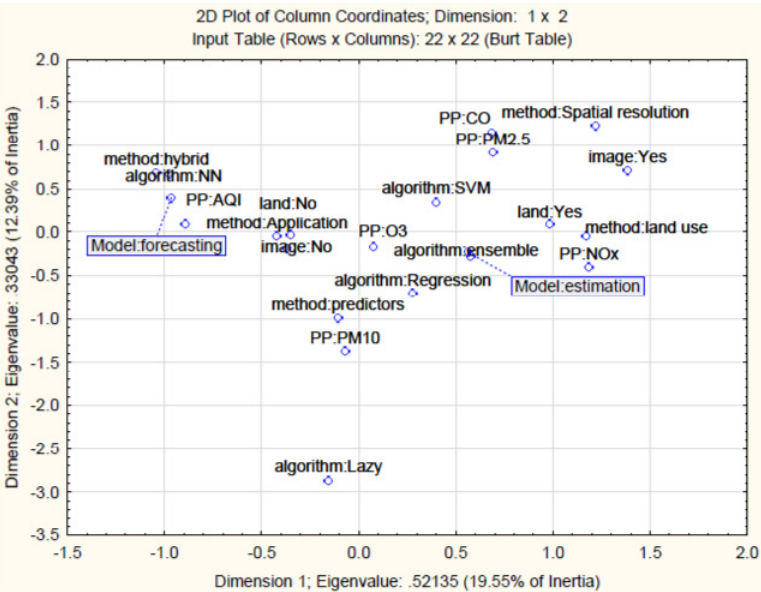
Fig. 4: Cloud point results obtained by using MCA characterizing all group articles